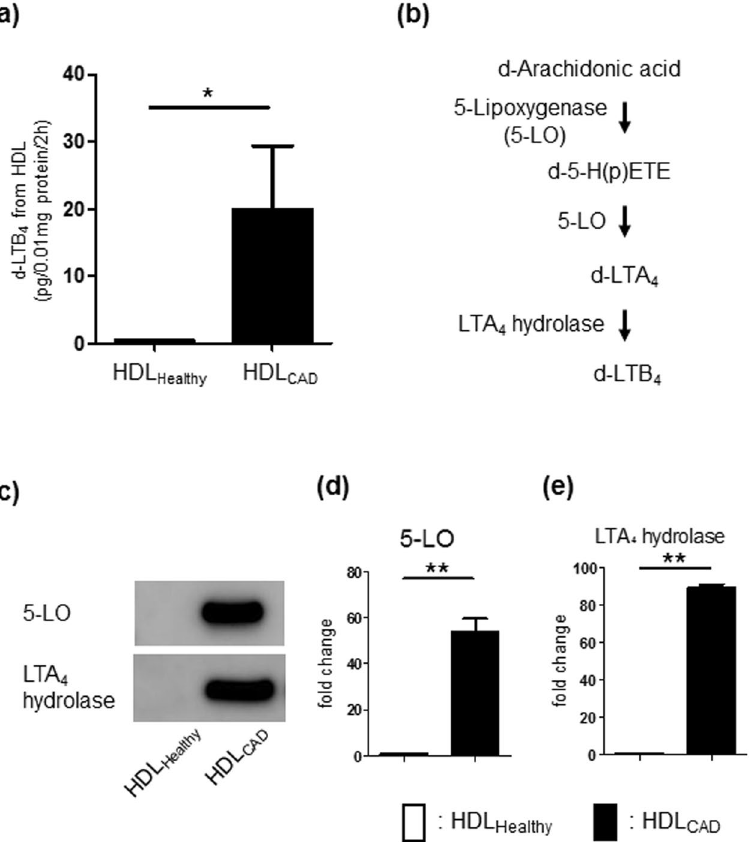
Figure 3. De novo LTB 4 production from HDL CAD . HDL (10 μ g) was incubated with 1 µ M deuterium-labelled (d-) substrates (d-AA, d-EPA and d-DHA) for 2 h at 37 °C, and then, the biosynthesis of d-LMs was analysed by LC/MS/MS. ( a ) d-LTB 4 biosynthesis from HDL. The results are shown as pg/0.01 mg of protein/2 h, mean ± SEM, N = 5. * P < 0.05. ( b ) The d-LTB 4 biosynthesis pathway from d-arachidonic acid is shown. ( c ) Western blot analysis showing 5-LO and LTA 4 hydrolase in HDL Healthy and HDL CAD . Fold changes in the protein expression in HDL CAD compared with those in HDL Healthy are shown. ( d ) 5-LO and ( e ) LTA 4 hydrolase. The results are shown as the mean ± SEM, N = 3. ** P <